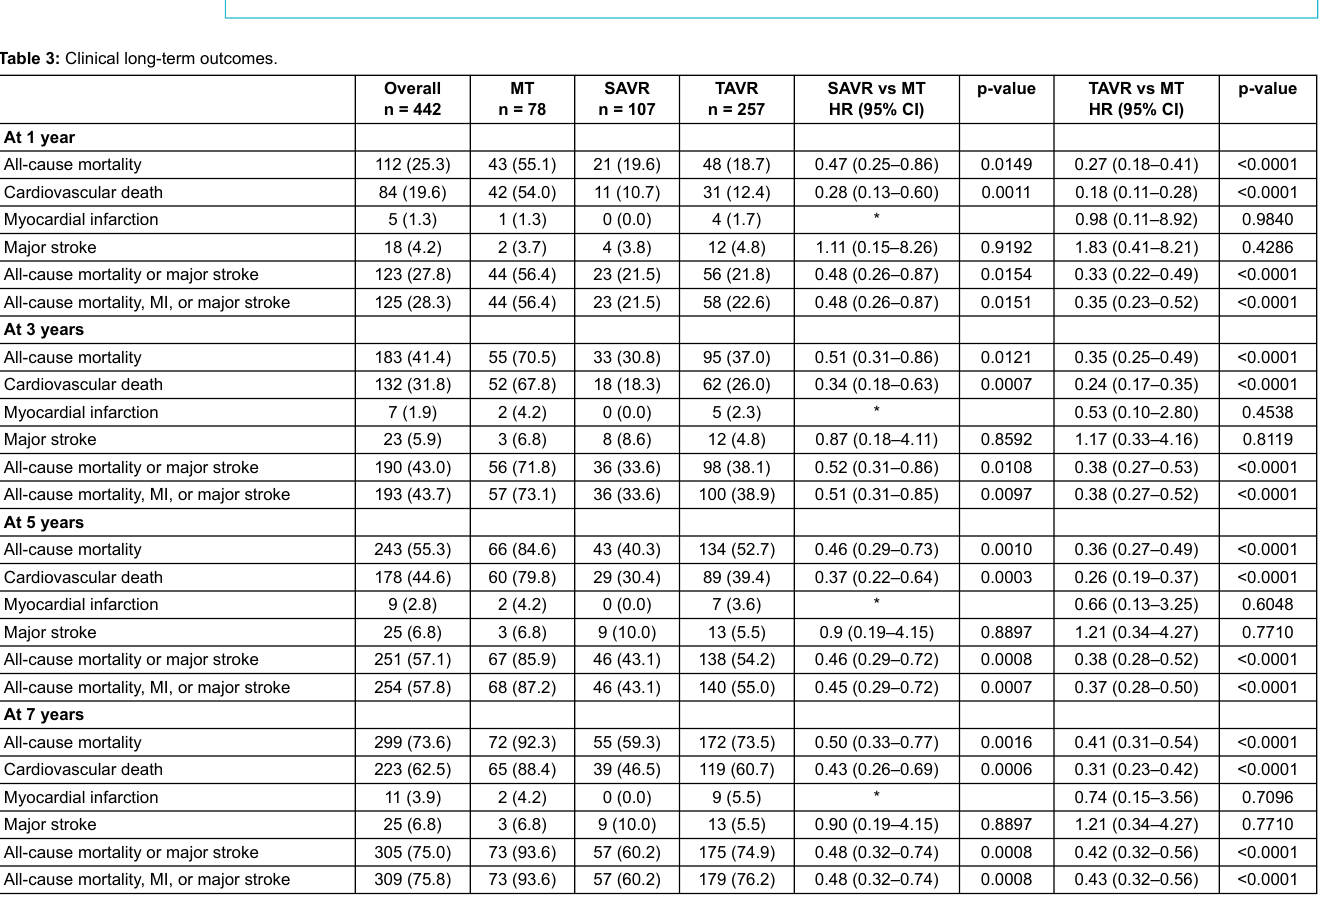
Table 3: Clinical long-term